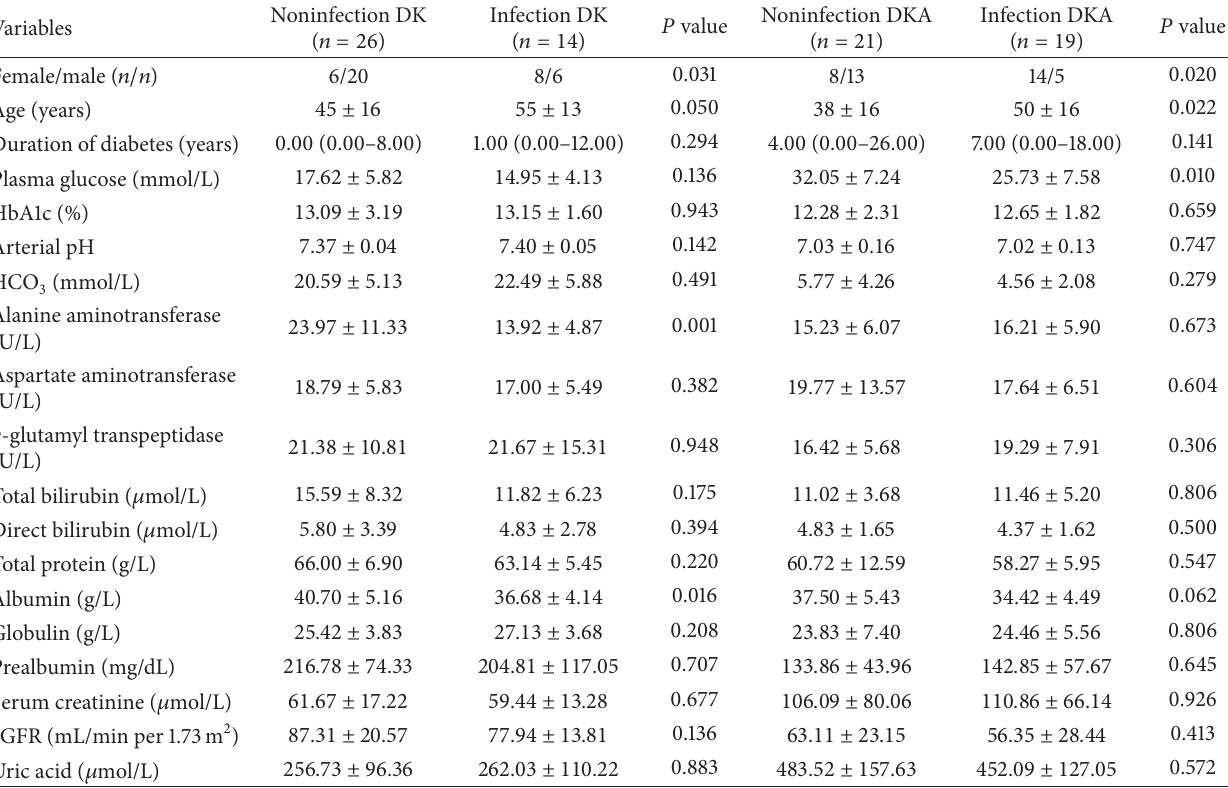
Table 3: Basal clinical and biochemical characteristics of the DK and DKA patients with and without infection.